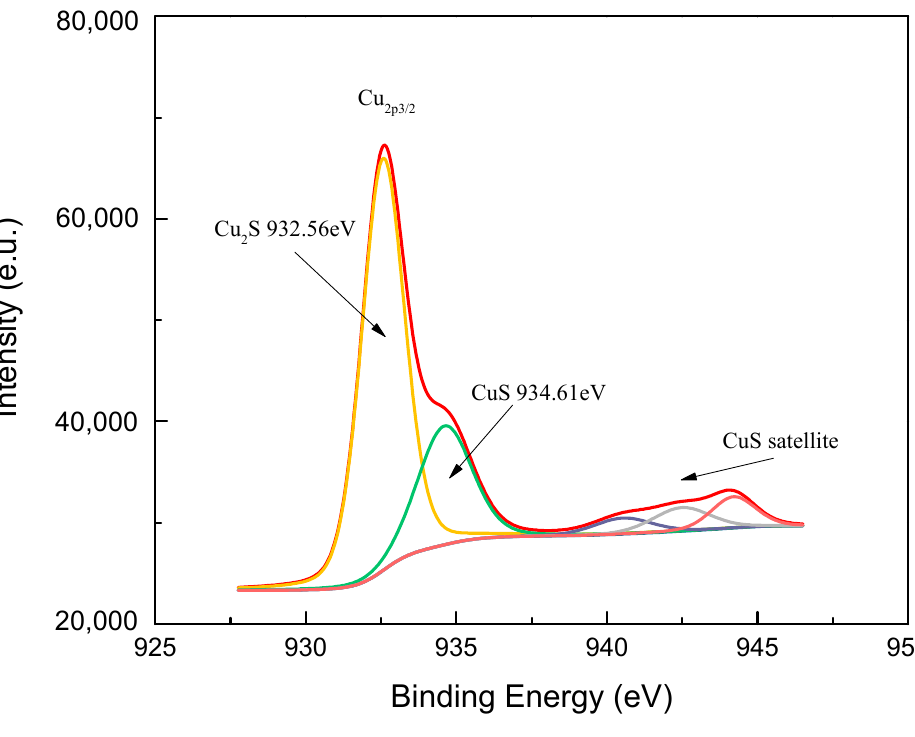
Figure 10. The XPS spectrum of Cu in hydrochar S5C5 after H 2 S adsorption.